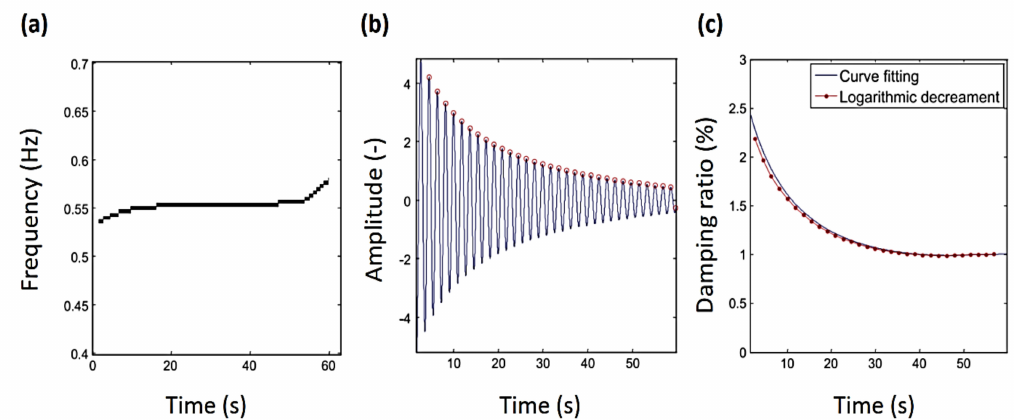
Figure 12. The first mode identification results of vibration of the analyzed tuned liquid column damper (TLCD): ( a ) Natural frequency, ( b ) vibration response, ( c ) damping ratio